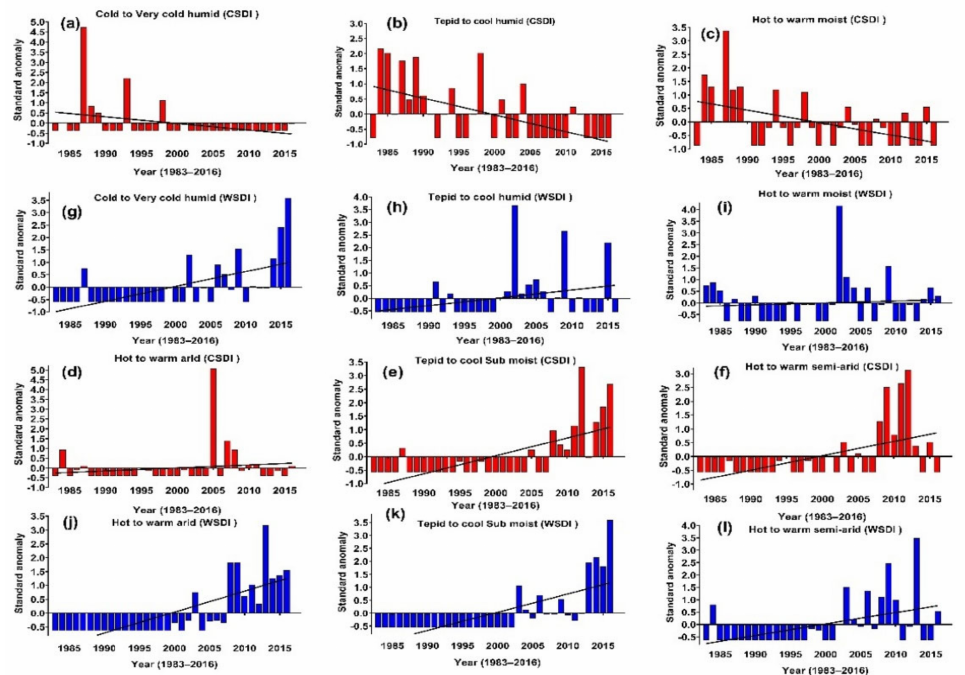
Figure 8. Cold spell duration indicator (CSDI) ( a – f ) and Warm spell duration indicator (WSDI) ( g – l ) over agroecological zones for the period